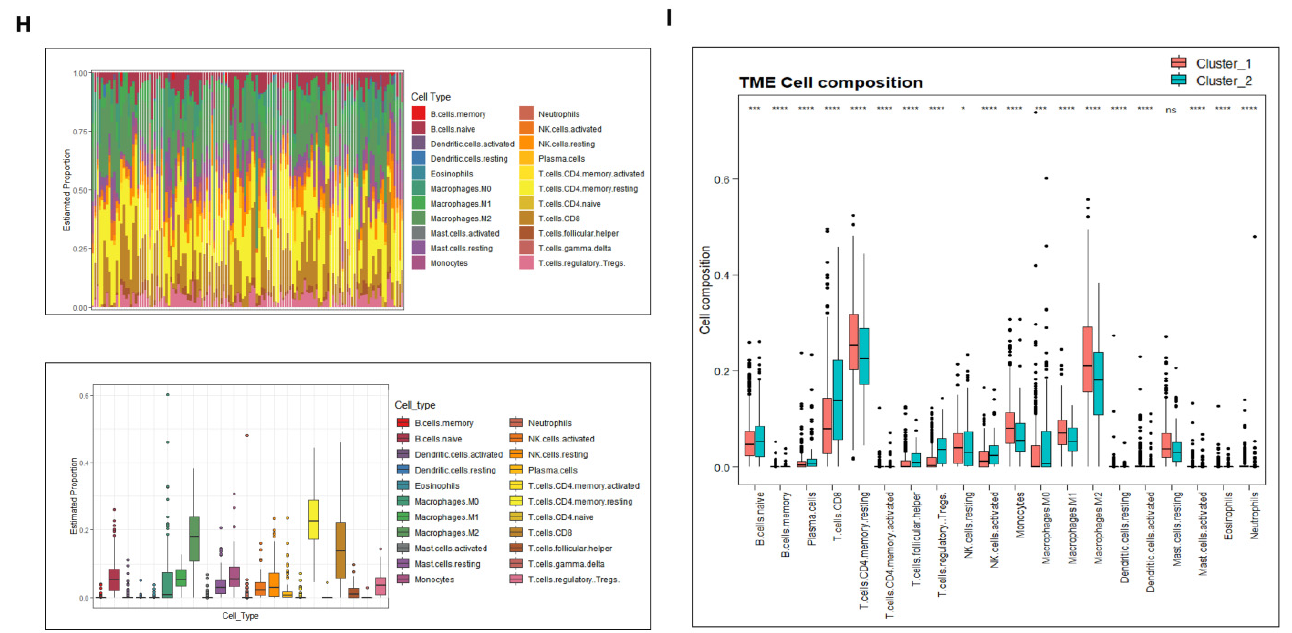
Figure 2. Consensus clustering analysis to evaluate the potential role of cuproptosis in ccRCC. ( A ) CDF and delta area analysis of category number k . ( B ) Consensus matrix when k = 2. ( C ) PCA analysis of CSS and CRS. ( D ) Expression heatmap of cuproptosis regulators in CSS and CRS. ( E ) A comparison of clinicopathological features between CSS and CRS. ( F ) CSS patients experienced longer survival as compared to CRS counterparts. ( G ) Estimated proportion of immune cells in CSS